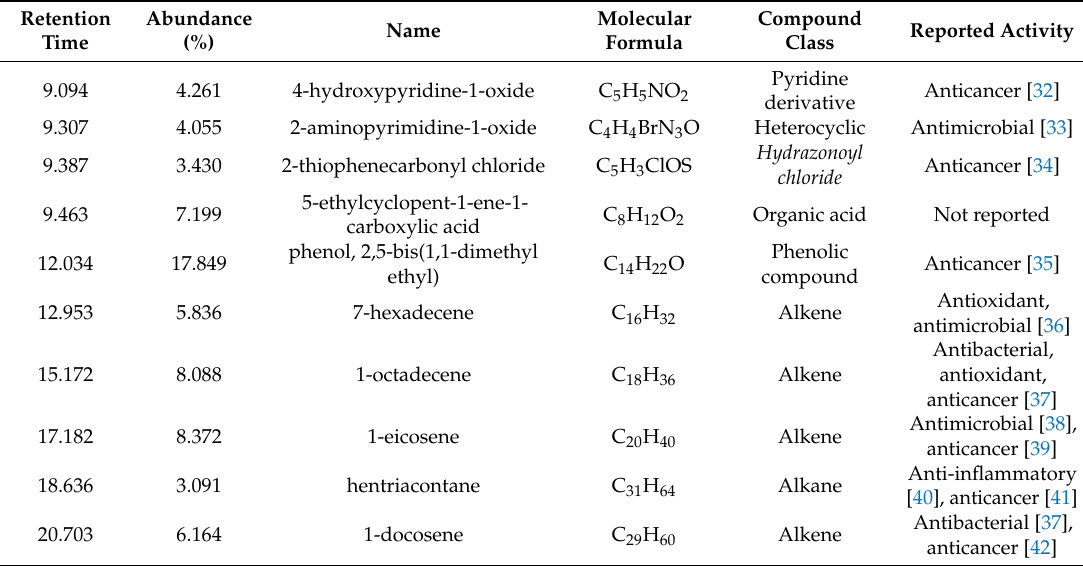
Table 2. Active compounds identified in the chloroform fraction of Nyctanthes arbor-tristis aqueous flower extract by as chromatography / mass spectrometry (GC / MS) analysis.